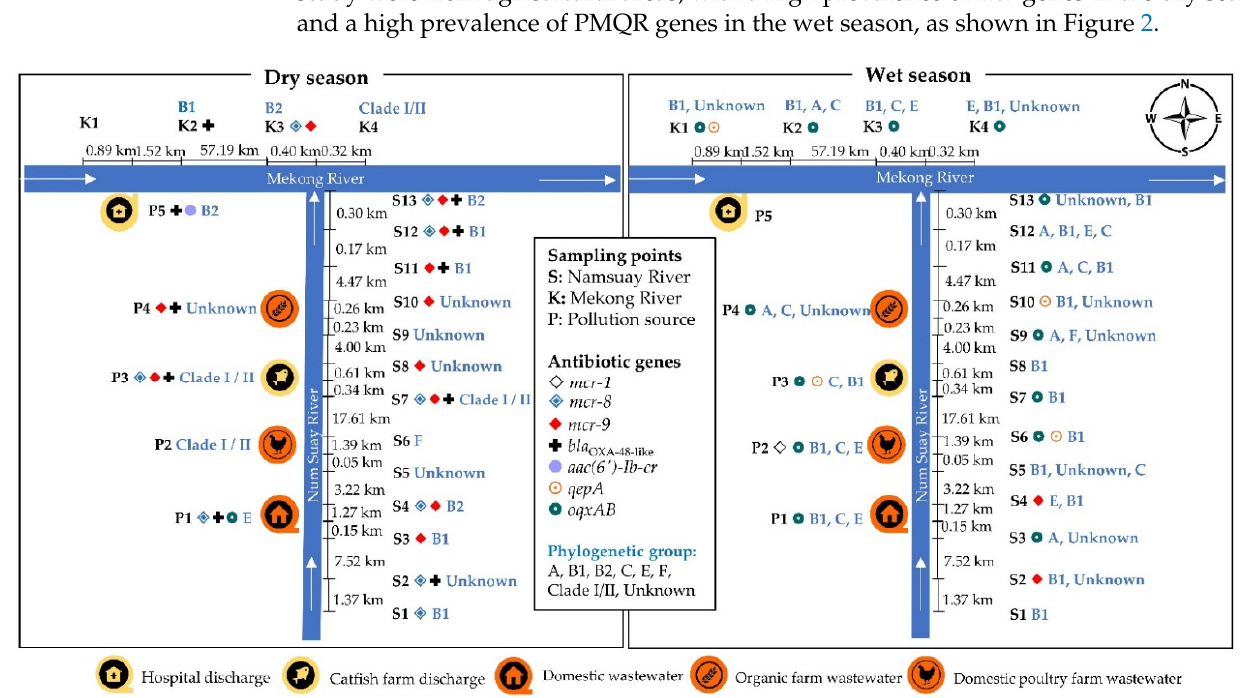
Figure 2. Distribution of the phylogenetic groups and antibiotic resistance genes, mcr Figure 2 . Distribution of the phylogenetic groups and antibiotic resistance genes, mcr (diamond symbol), CEGs (plus symbol) and PMQR (circle symbol) of E. coli at the water sample points.